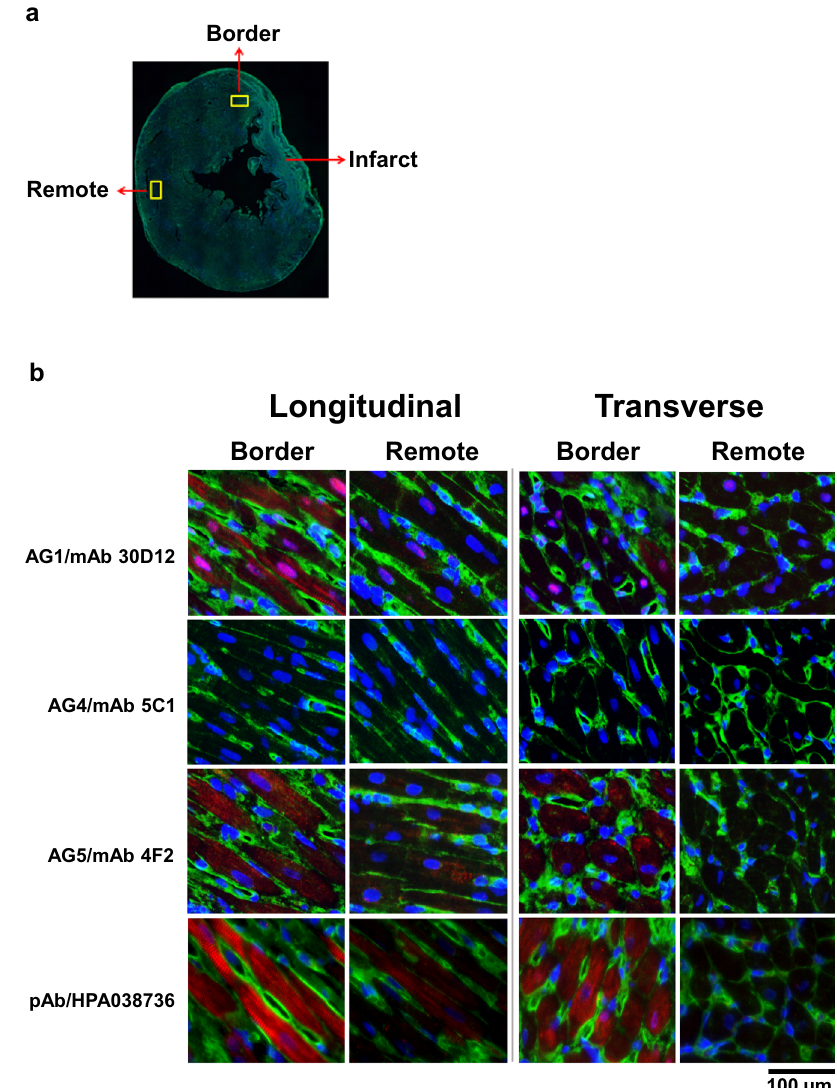
Fig. 7 Rat ANKRD1 is localized in the nucleus and sarcomere, and is upregulated in response to cardiac insult. a Transverse section of rat heart tissue (post-MI day 7) showing the border, remote and infarcted zones. b Immuno fl uorescence staining for rANKRD1 in post-MI day-7 rat heart tissue. The regions that are at the border or remote from the infarcted zone are examined in the longitudinal and transverse orientation. rANKRD1 is labeled by Alexa Fluor 594 (red), the cytoplasm by Alexa Fluor 488 (green) and nucleus by DAPI (blue). The merged image reveals that rANKRD1 is upregulated in the border region and is present in both the cytoplasm (localized in the myo fi brils) and nucleus of